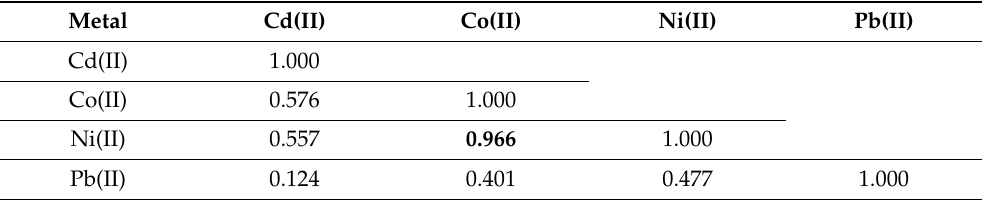
Table 5. Pearson correlation coefficients matrix 1 for normalized sorption capacity (Q t ’) of Cd(II), Co(II), Ni(II) and Pb(II) among the studied metal ions.